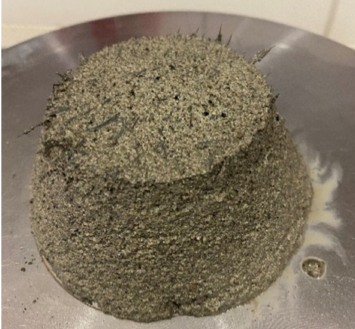
Figure 3. Improper dispersion of carbon fibres in fresh